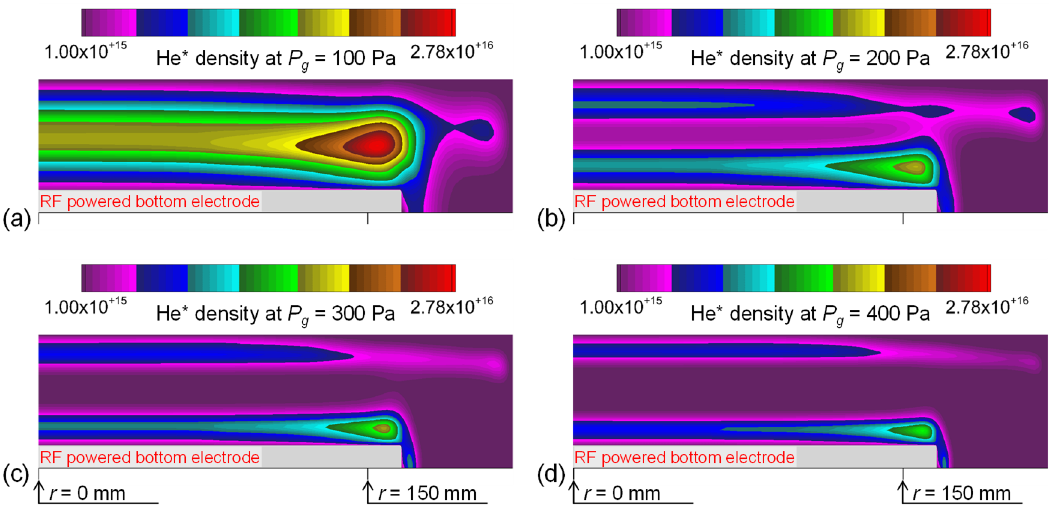
Figure 4. The spatial profiles of the time-averaged He* density (m − 3 ) ( a ) for Case 5, ( b ) for Case 6, ( c ) for Case 7, and ( d ) for Case